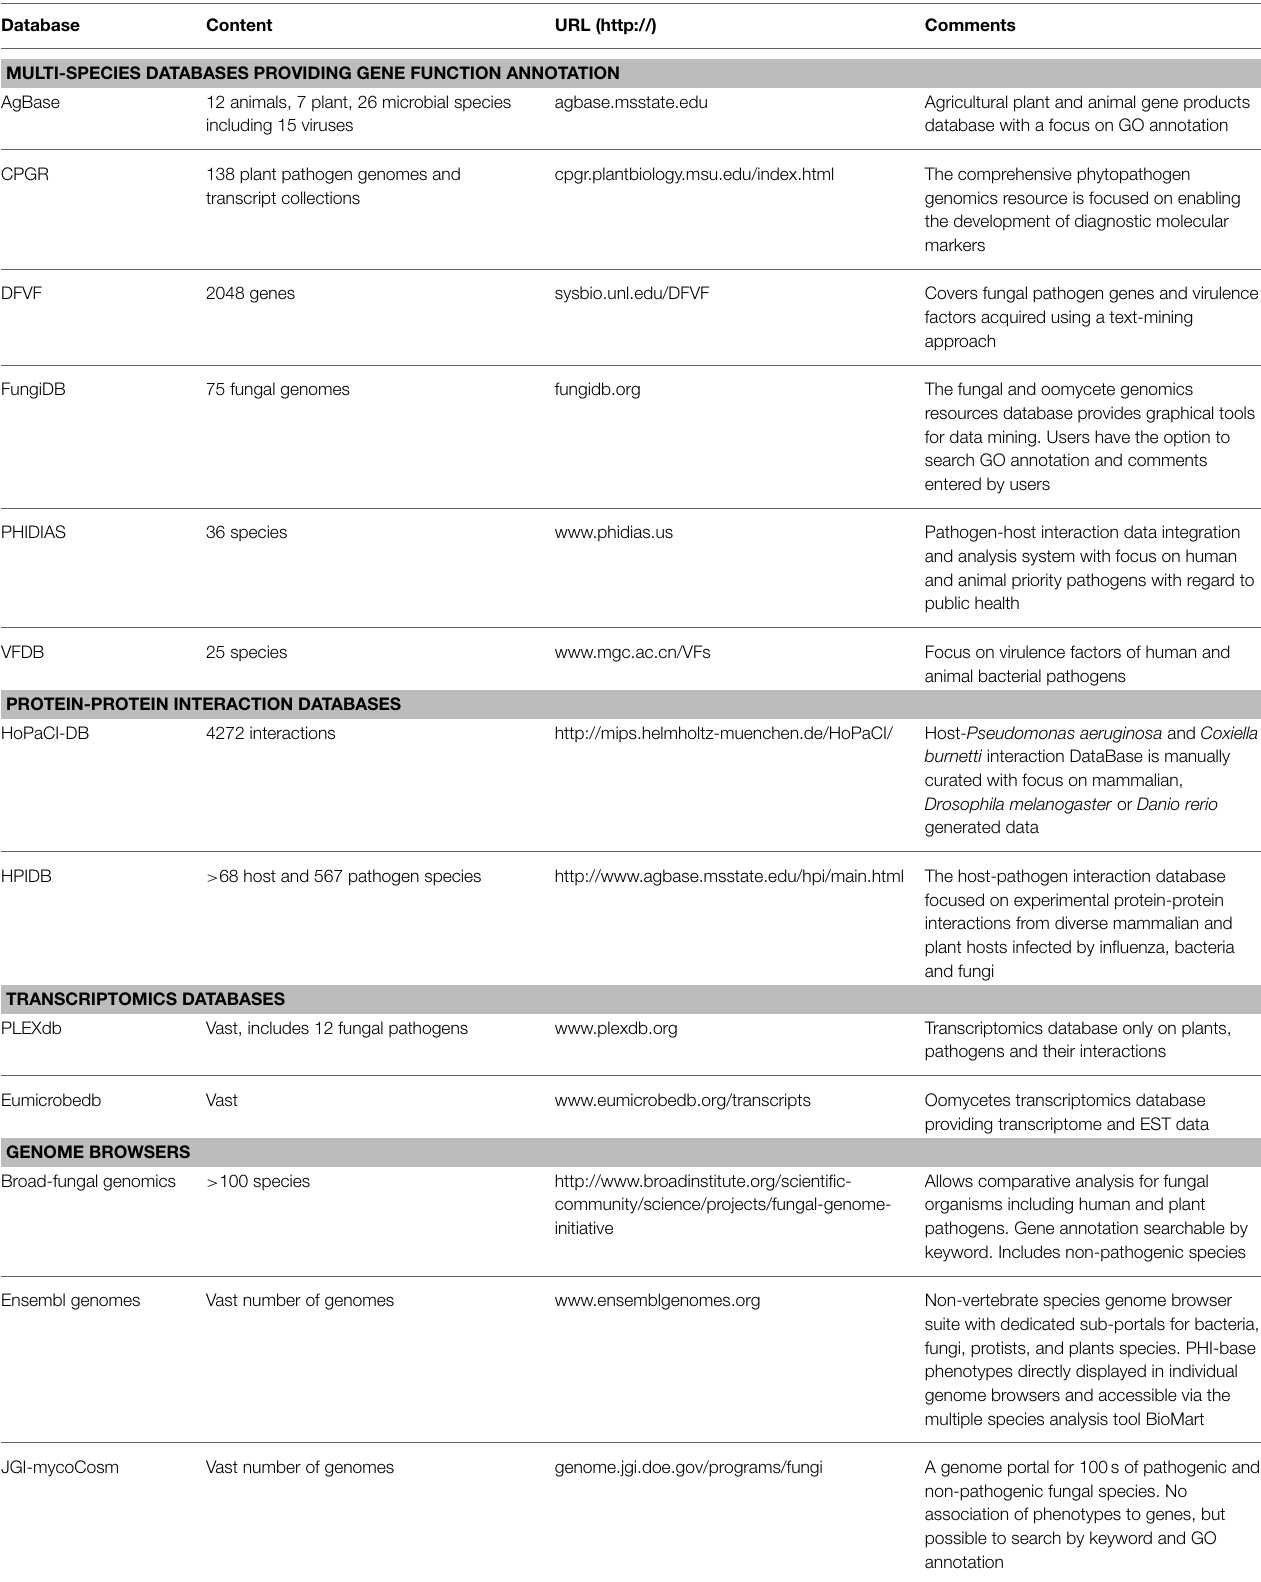
TABLE 2 | Synopsis of complementary multi-species pathogen databases and their specialisms a .